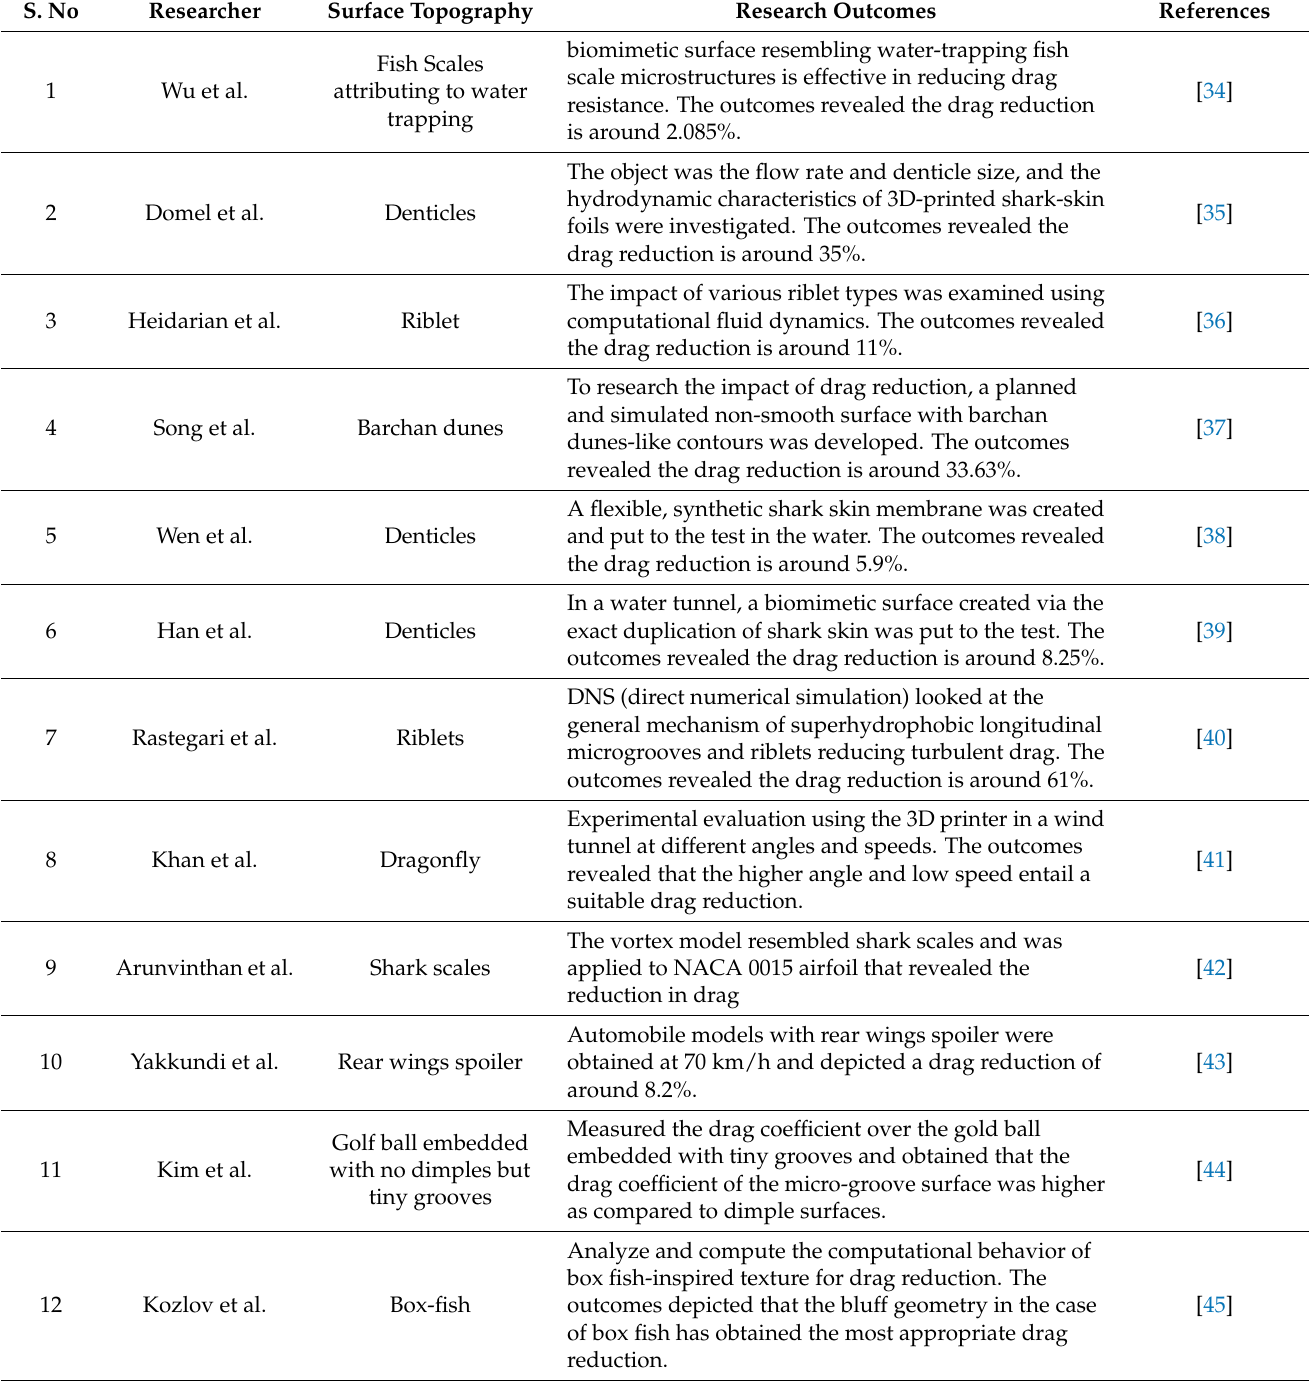
Table 1. Biomimetic surfaces used for drag